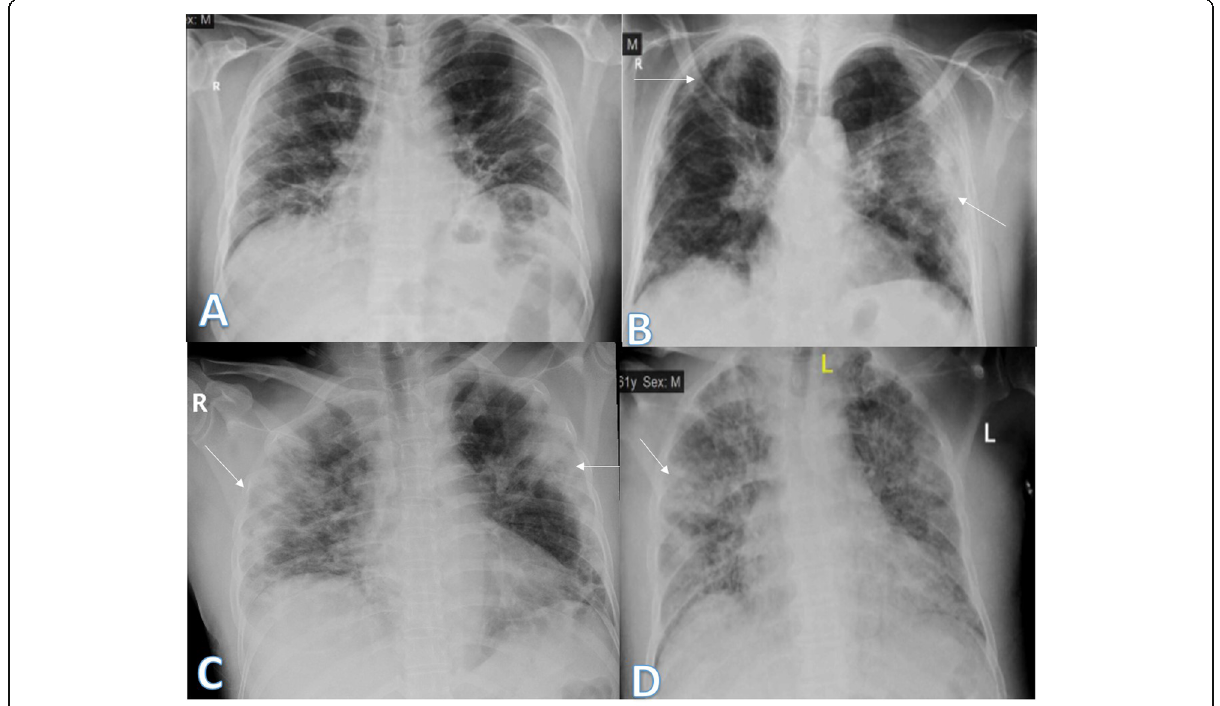
Fig. 8 Four different patients with positive COVID-19. a 48-year male, b 48-year male, c 46-year male, and d 61-year male, follow-up chest X-ray showed bilateral diffuse reticular interstitial lung thickening with air space consolidation opacities were still seen